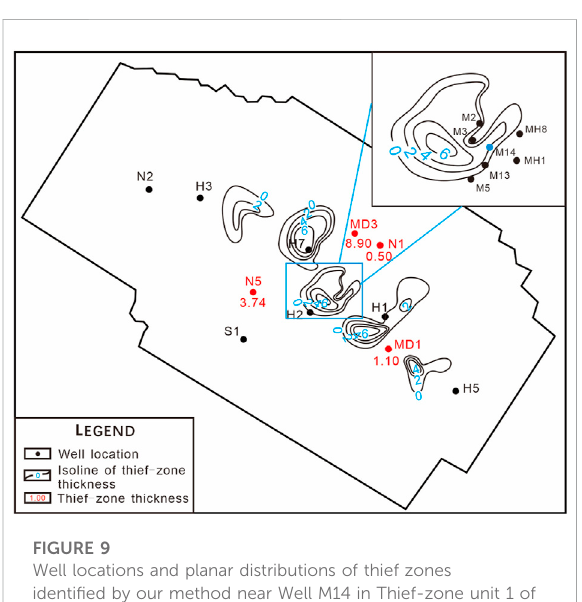
Well locations and planar distributions of thief zones identi fi ed by our method near Well M14 in Thief-zone unit 1 of